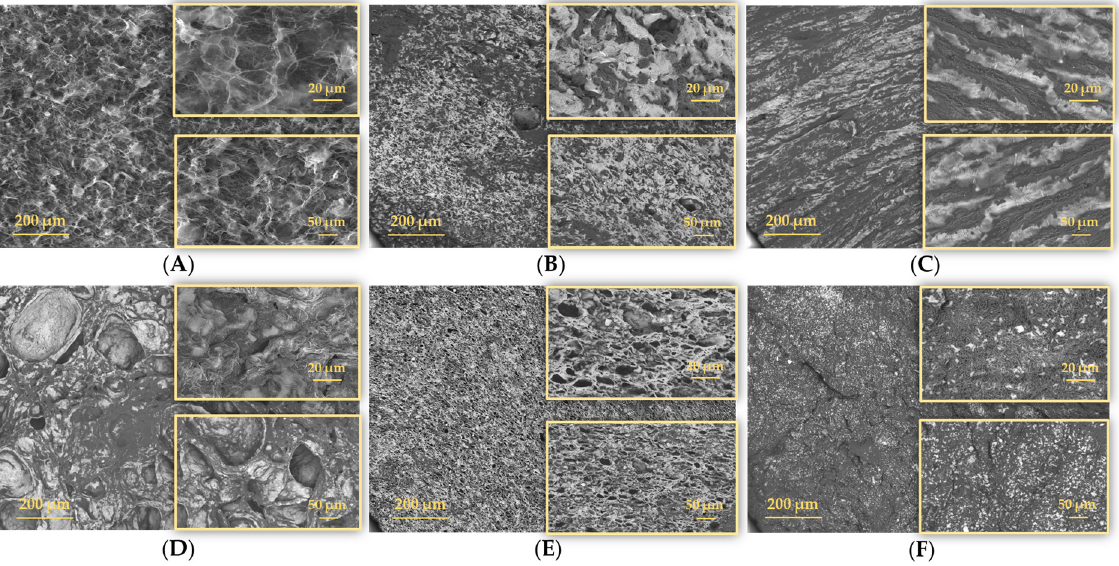
Figure 2. Comparative SEM images of the cryogels: ( A ) PVA_PEBSA 50/50 , ( B ) PVA_PEBSA 25/75 _Thy_ α -Tcp, ( C ) PVA_PEBSA 50/50 _Thy_ α -Tcp, ( D ) PVA_PEBSA 75/25 _Thy_ α -Tcp, ( E ) PVA_PEBSA 50/50 _2xThy_ α -Tcp, and ( F ) PVA_PEBSA 50/50 _Thy_2x α -Tcp.